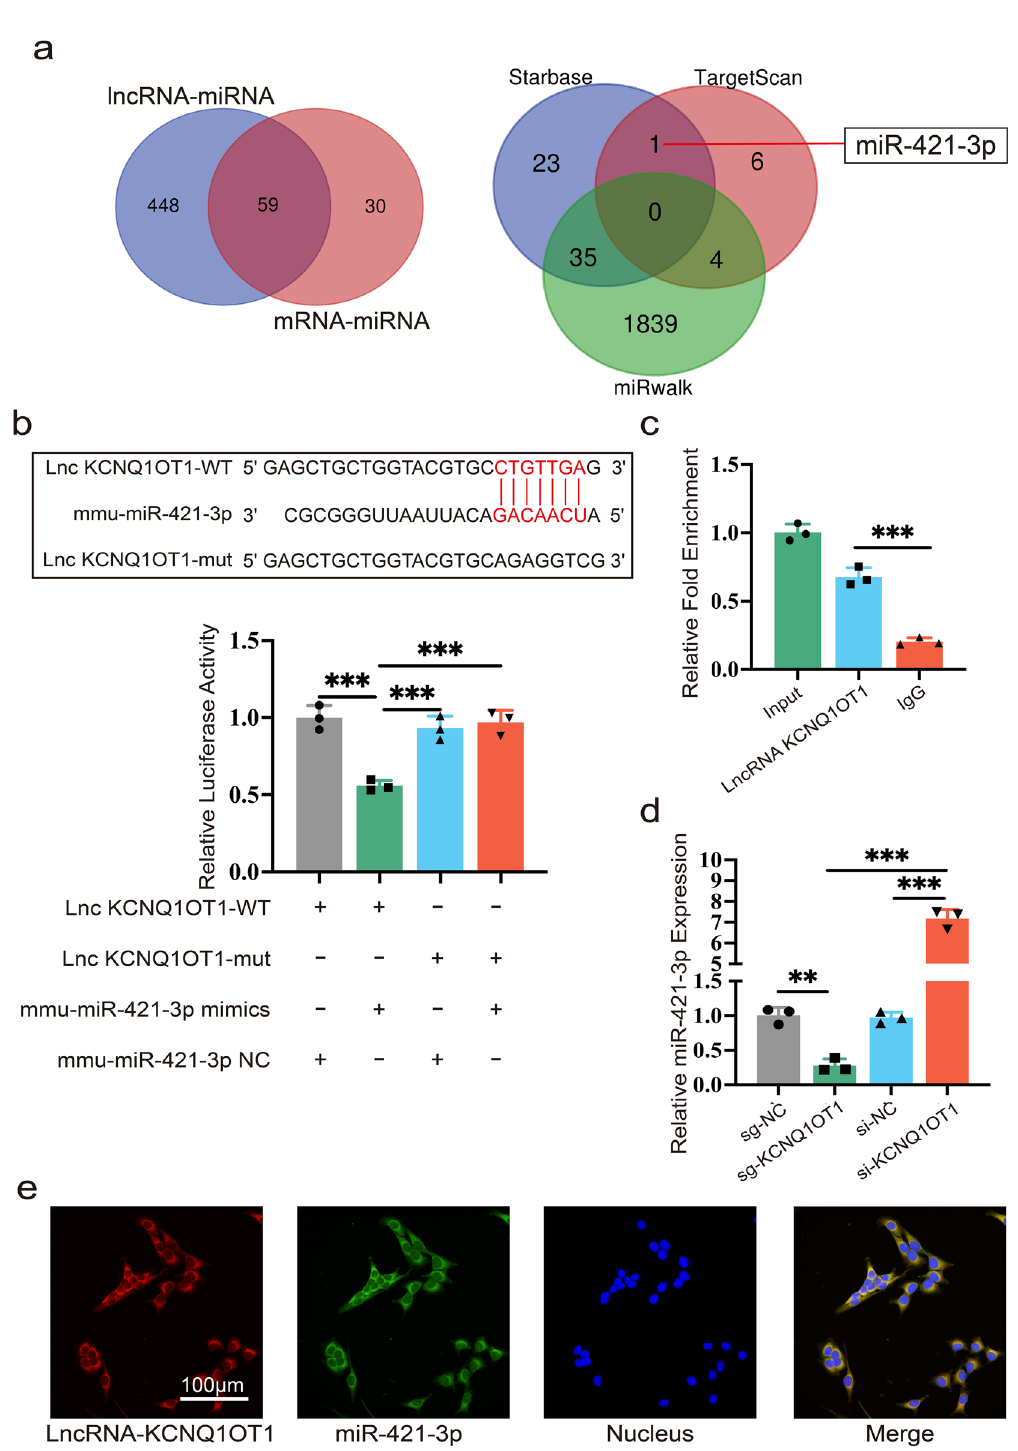
Figure 2. KCNQ1OT1 directly interacts with miR-421-3p. ( a ) Bioinformatic databases predicted that miR-421-3p could be a possible target of KCNQ1OT1. ( b ) The binding site between KCNQ1OT1 and miR- 421-3p was predicted by Starbase. After HEK-293T cells transfected with mmu-421-3p NC or mmu-miR- 421-3p mimics in wild-type (WT) and mutanttype (mut) of KCNQ1OT1, a dual luciferase reporter assay was performed. ( c ) The RIP assay was completed using input from cell lysate, IgG, or anti-Ago 2, relative RNA expression levels were presented as fold enrichment in Ago2 relative to IgG IP. ( d ) Relative miR-421-3p expression in MC3T3-E1 cells transfected with sg-KCNQ1OT1, sg-NC, si-KCNQ1OT1 and si-NC. ( e ) The location of KCNQ1OT1 and miR-421-3p were both in cytoplasm of MC3T3-E1 cells via RNA-FISH assay. **P < 0.01, ***P <